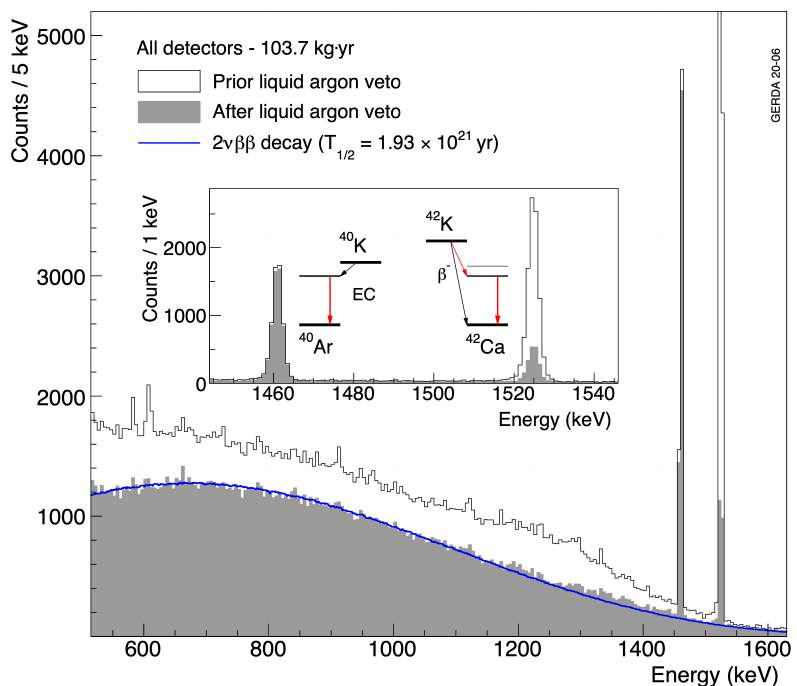
Figure 21. The impact of the LAr cut on the 40 K and 42 K lines and their Comptons.